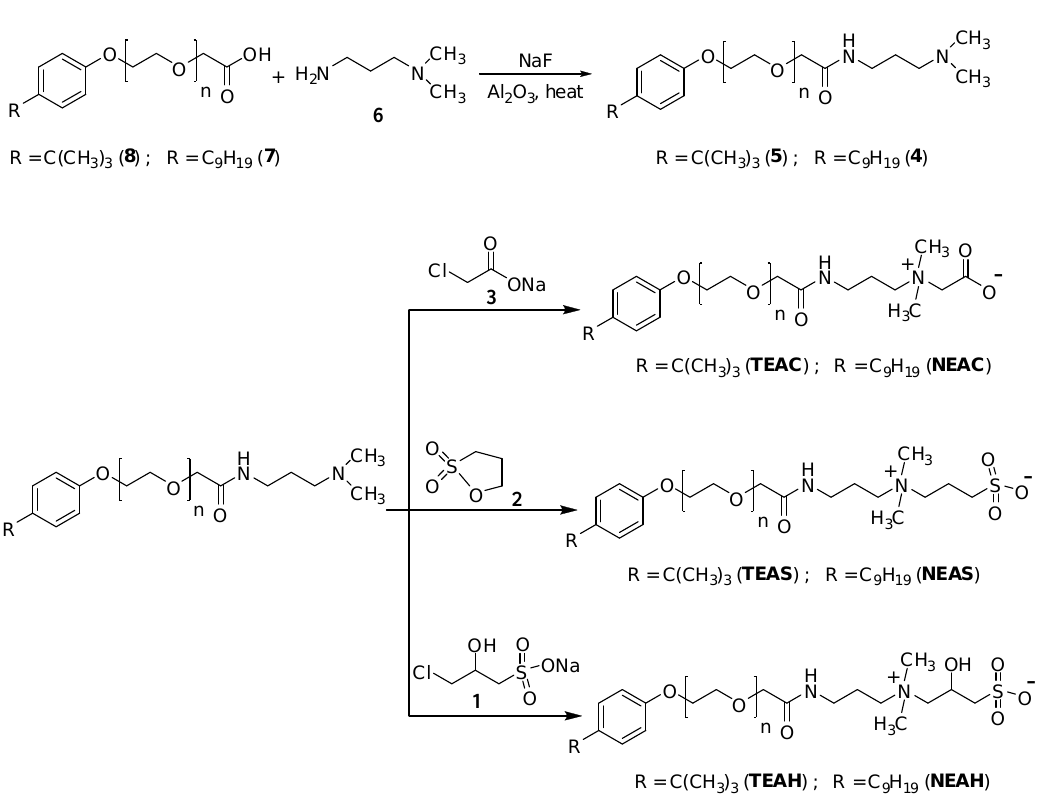
Figure 1. Carbon-13 Nuclear Magnetic Resonance (NMR) of the intermediate compound ( 5 ).